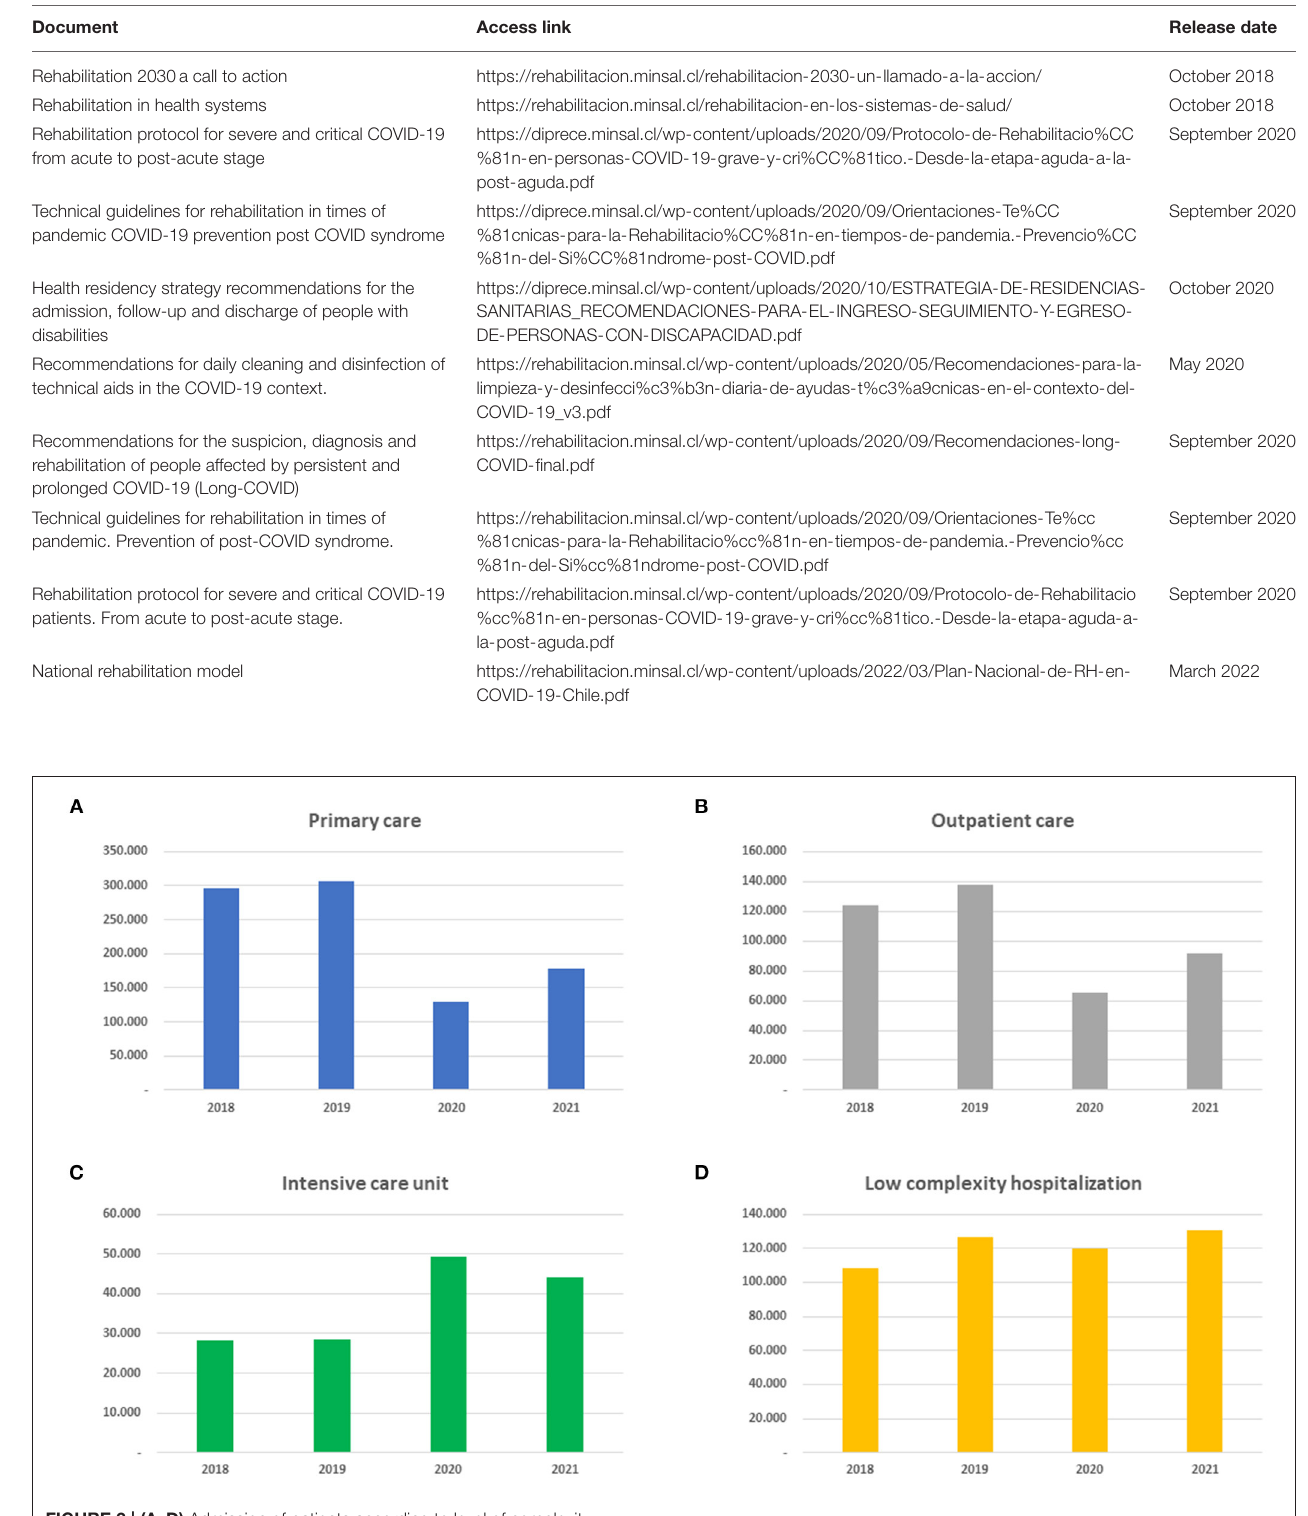
TABLE 2 | Documents related to rehabilitation generated by MINSAL.